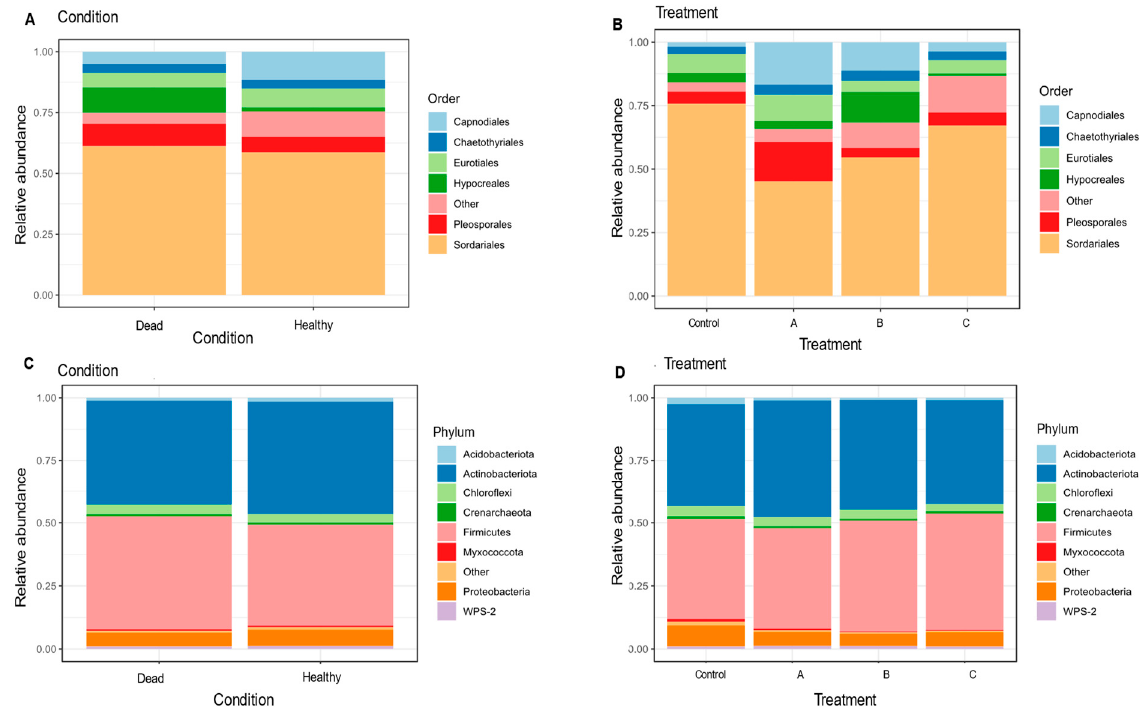
Figure 3. Relative abundances: ( A ) the relative abundance of fungi orders depending on the plant condition; ( B ) relative abundance of fungi depending on the treatment; ( C ) relative abundance of bacterial phyla depending on the plant condition; and ( D ) relative abundance of bacterial phyla depending on the treatment.